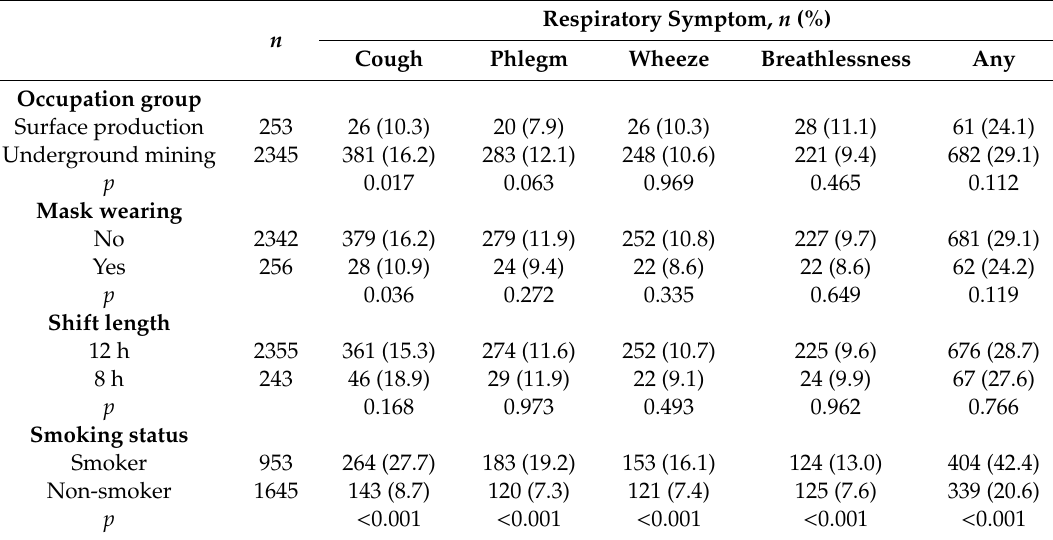
Table 4. Prevalence of respiratory symptoms by occupation group, mask wearing status, and work shift length ( n = 2598).